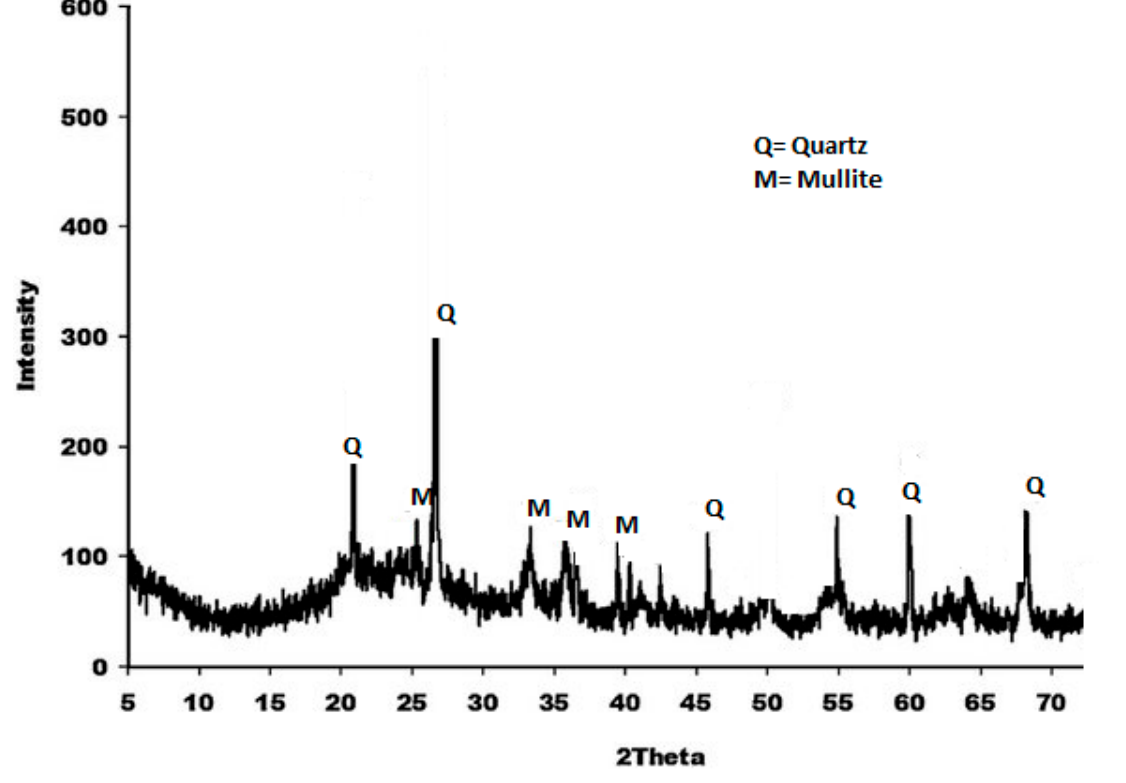
Figure 1. XRD pattern of bagasse ash.